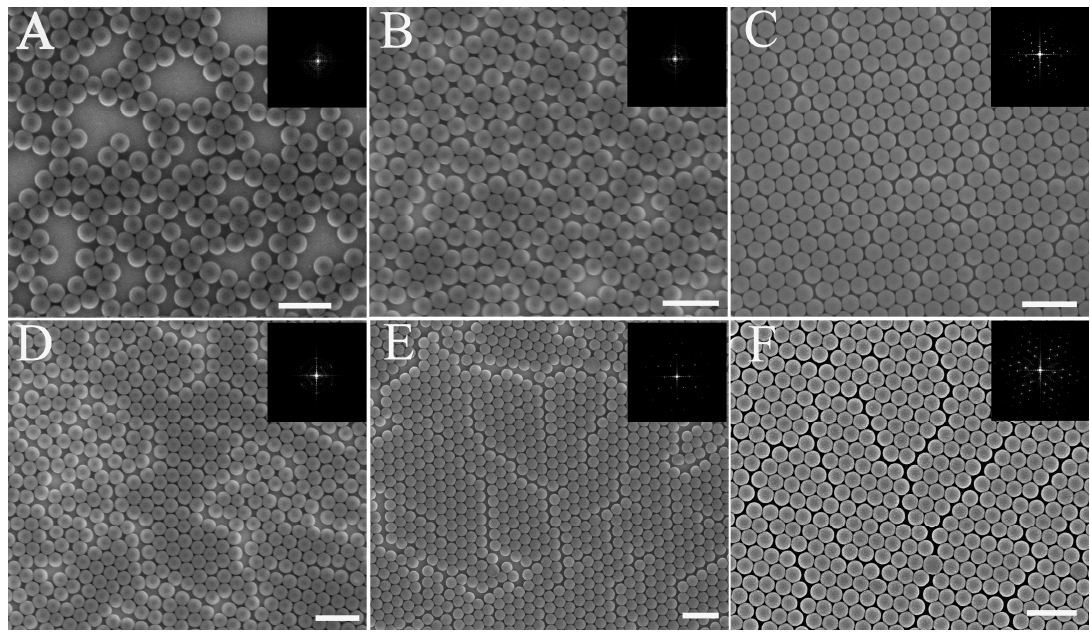
Figure 3. Influence of SDS concentration on monolayer formation for low PS concentrations (upper row, 1 wt. %) and high PS concentration (lower row, 2 wt. %). The SDS concentrations were ( A , D ) non-SDS, ( B , E ) 2 wt. %, ( C , F ) 4 wt. %. (Scale bar 1 µ m, all colloidal crystals had been transferred to the